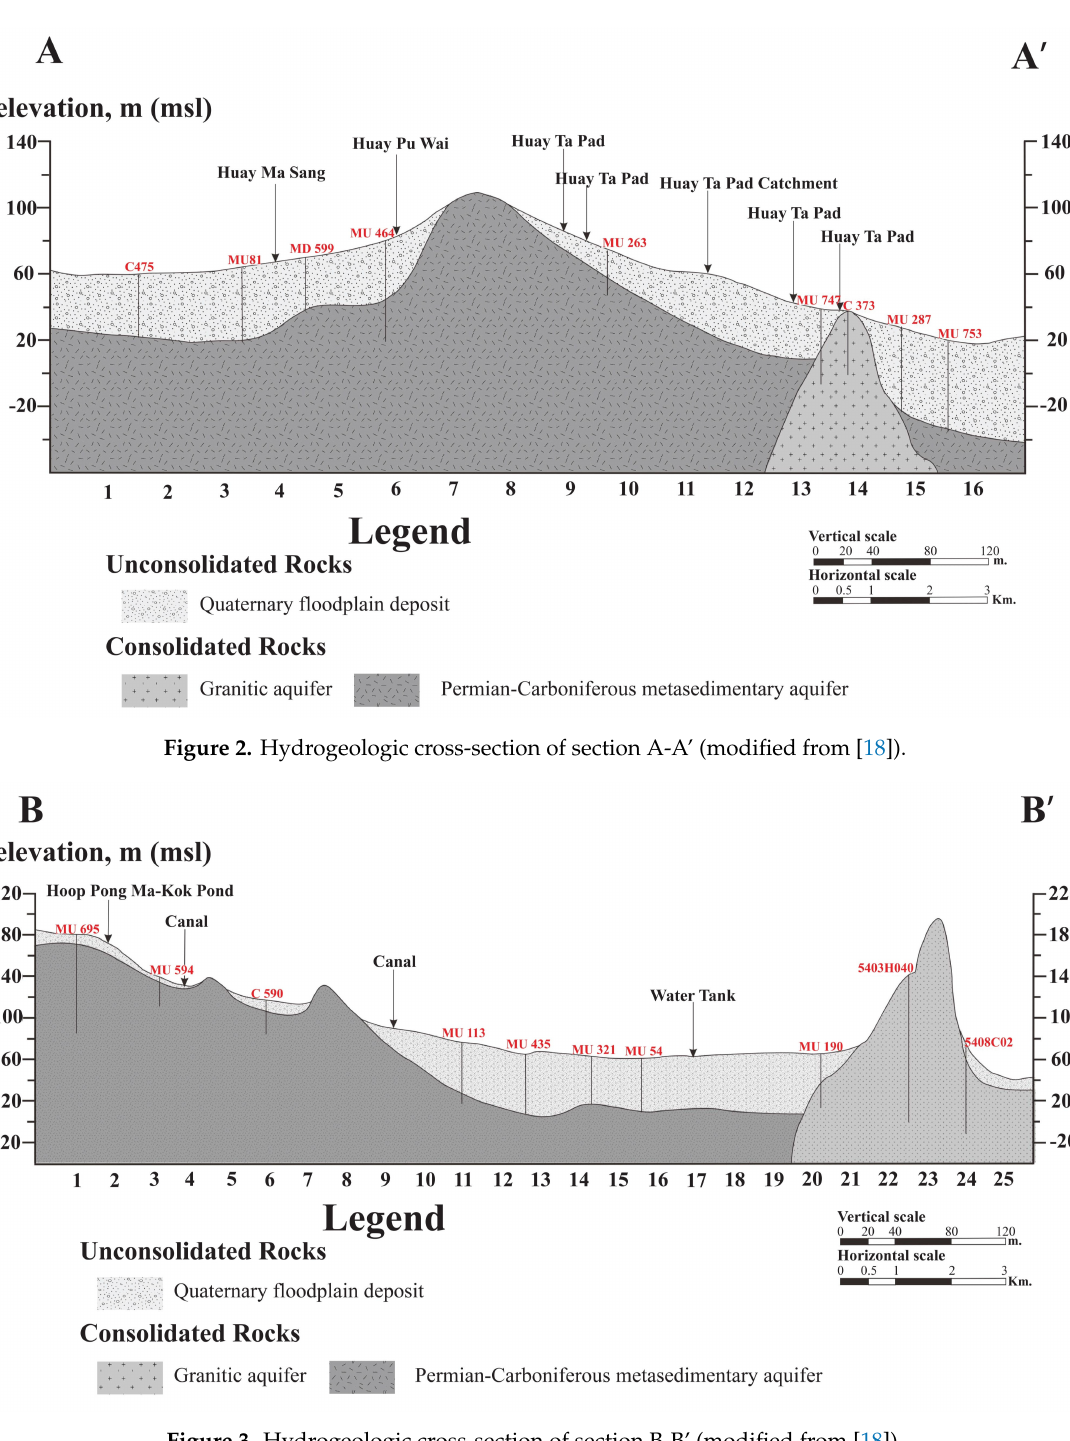
Figure 3. Hydrogeologic cross-section of section B-B’ (modified from